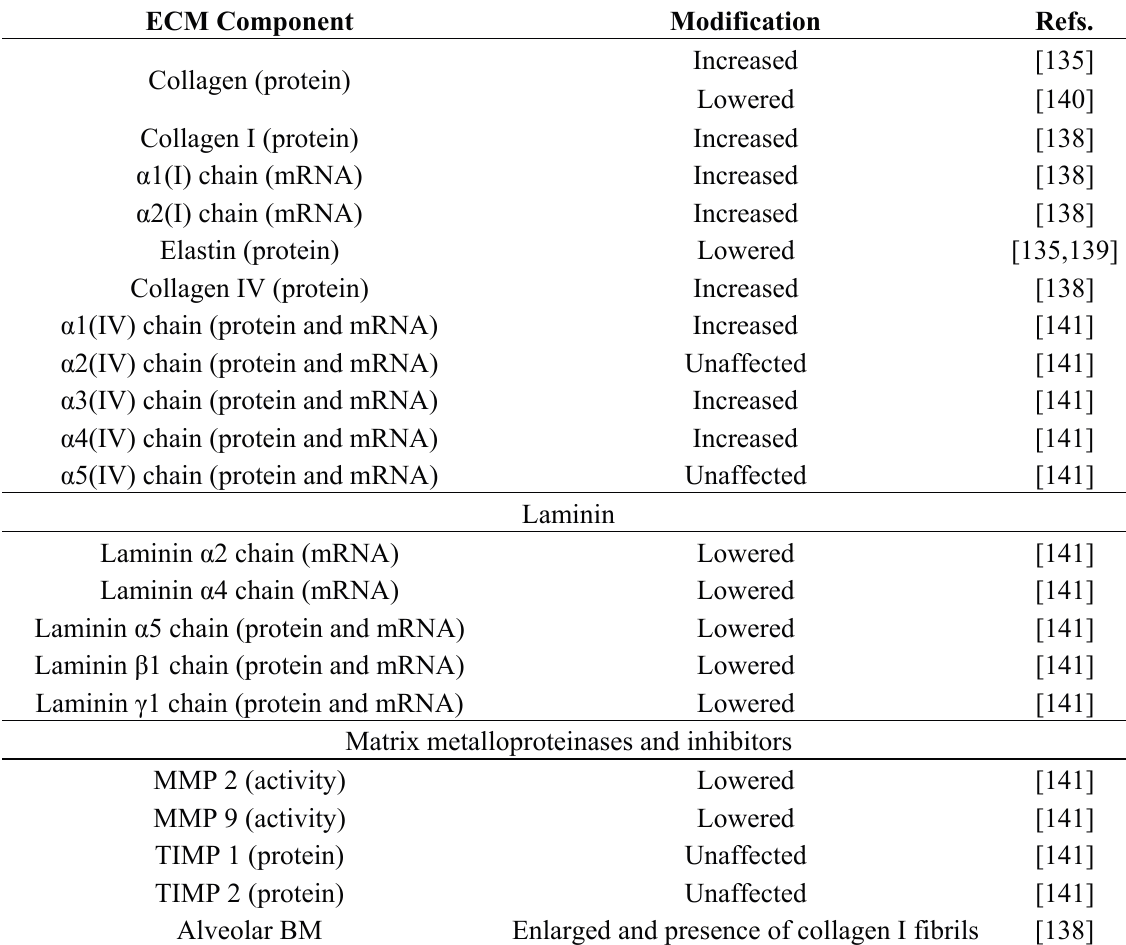
Table 2. Lung ECM alterations in chronic vitamin A